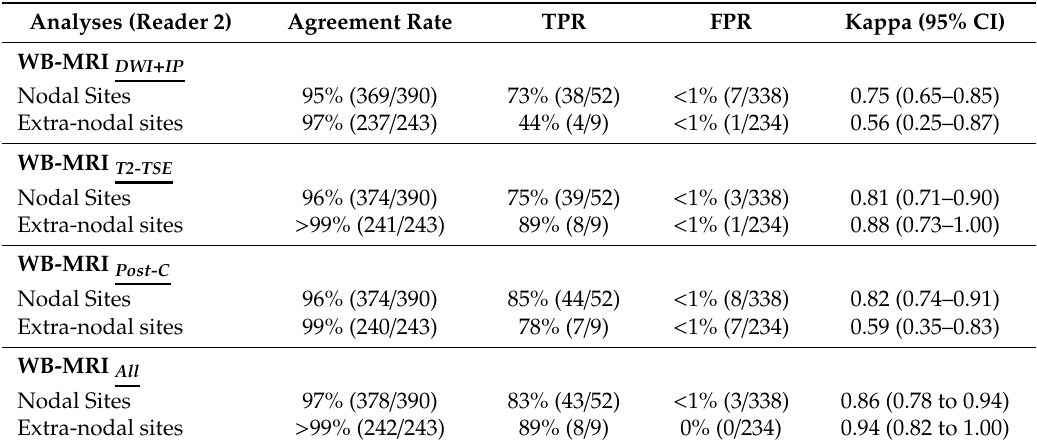
Table 4. Comparison of di ff erent MRI sequences as part of the WB-MRI protocol for nodal and extra-nodal disease evaluation for reader 2.